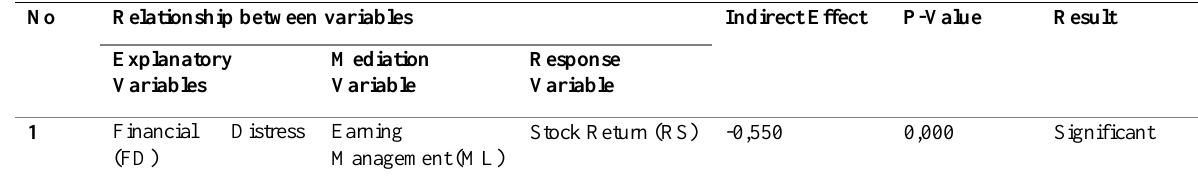
Table 3: Testing of Mediation Variables Model 1 (Altman)